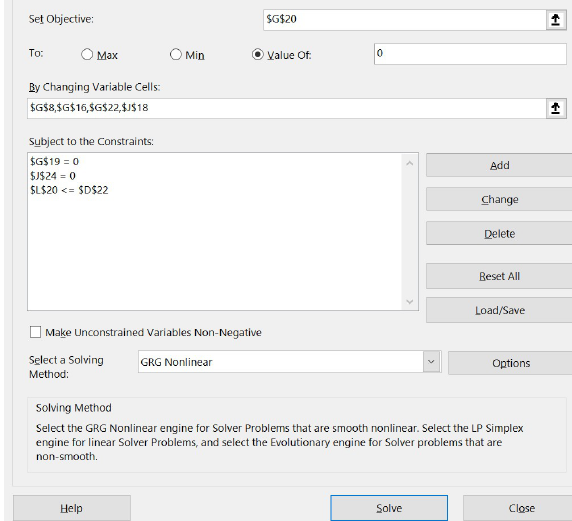
Fig. 7. GRG nonlinear programming of Excel-Solver parameters